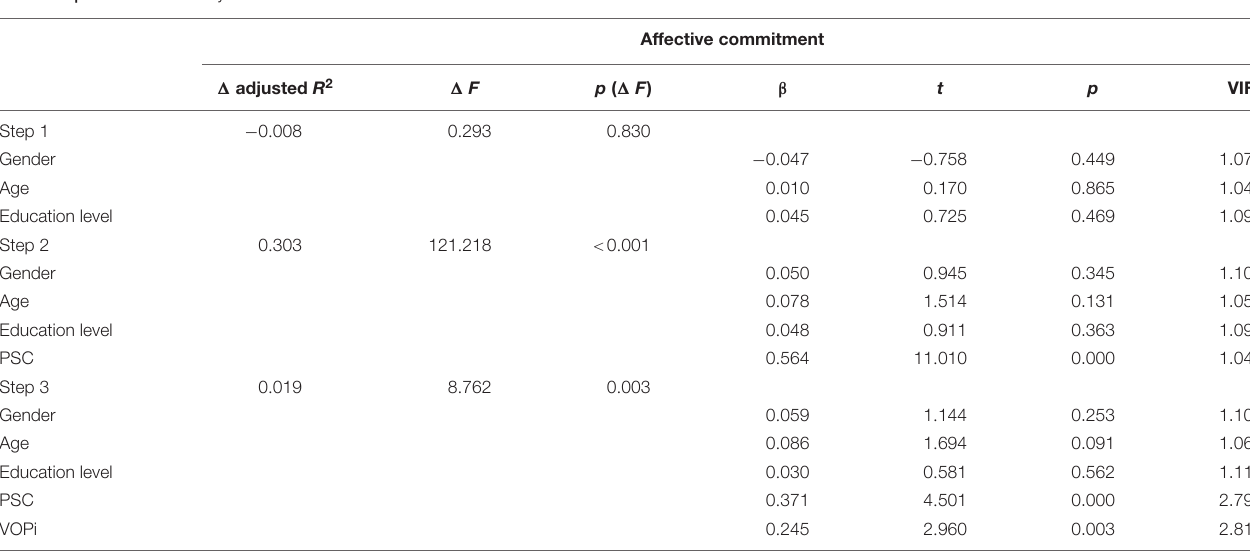
TABLE 8 | Incremental validity of VOPi on affective